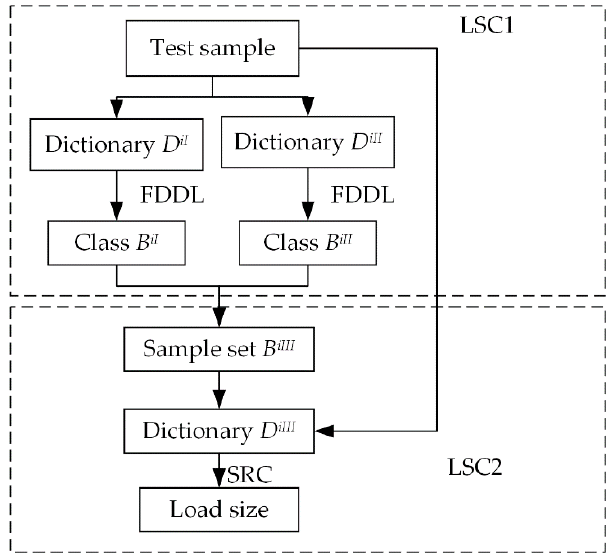
Figure 10. Algorithm flow for load-size classifiers LSC 1 and LSC2.